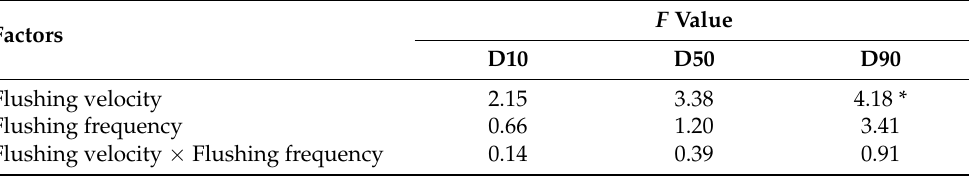
Table 4. Variance analysis of the effects of flushing velocity and flushing frequency on the particle size of discharged sediments.